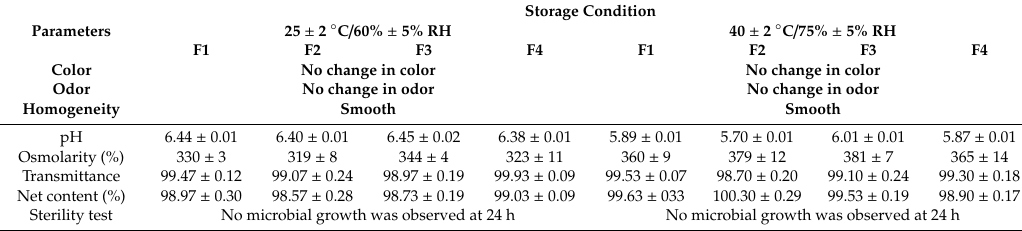
Table 4. Long-term and accelerated test of USL eye drop formulations for 4 weeks.